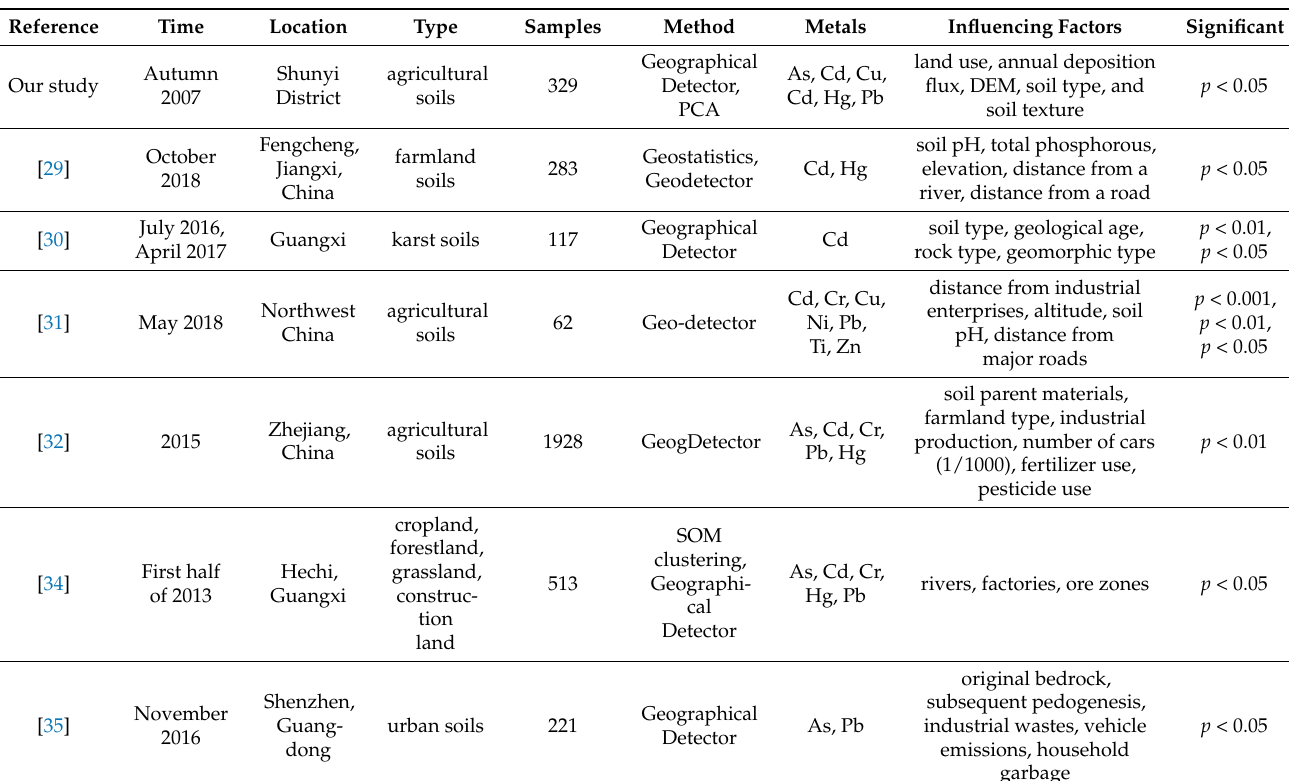
Table 6. The comparative results between this study and existing